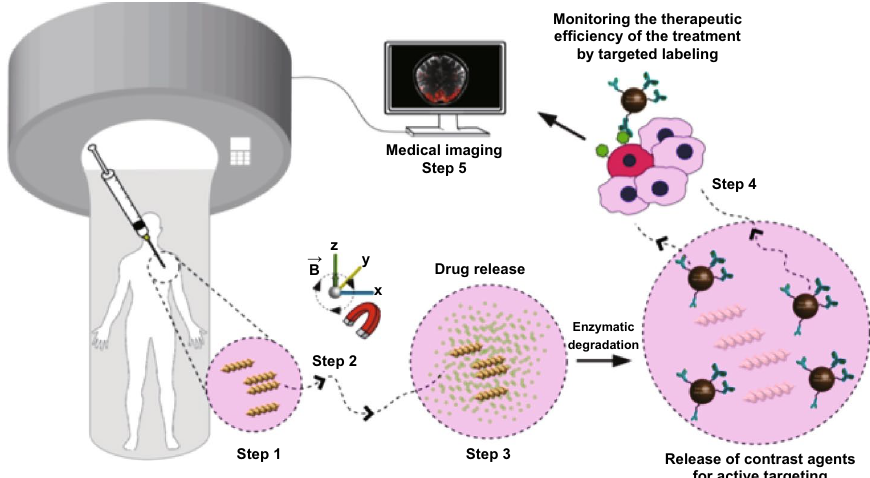
Fig. 8 3D-printed biodegradable microswimmer for theranostic cargo delivery and envisioned theranostic application scenario of the 3D-printed biodegradable microswimmer. Adapted from Ref. [98] with permission, copyright from American Chemical Society, 2019. Notice: further permissions related to this material excerpted should be directed to the